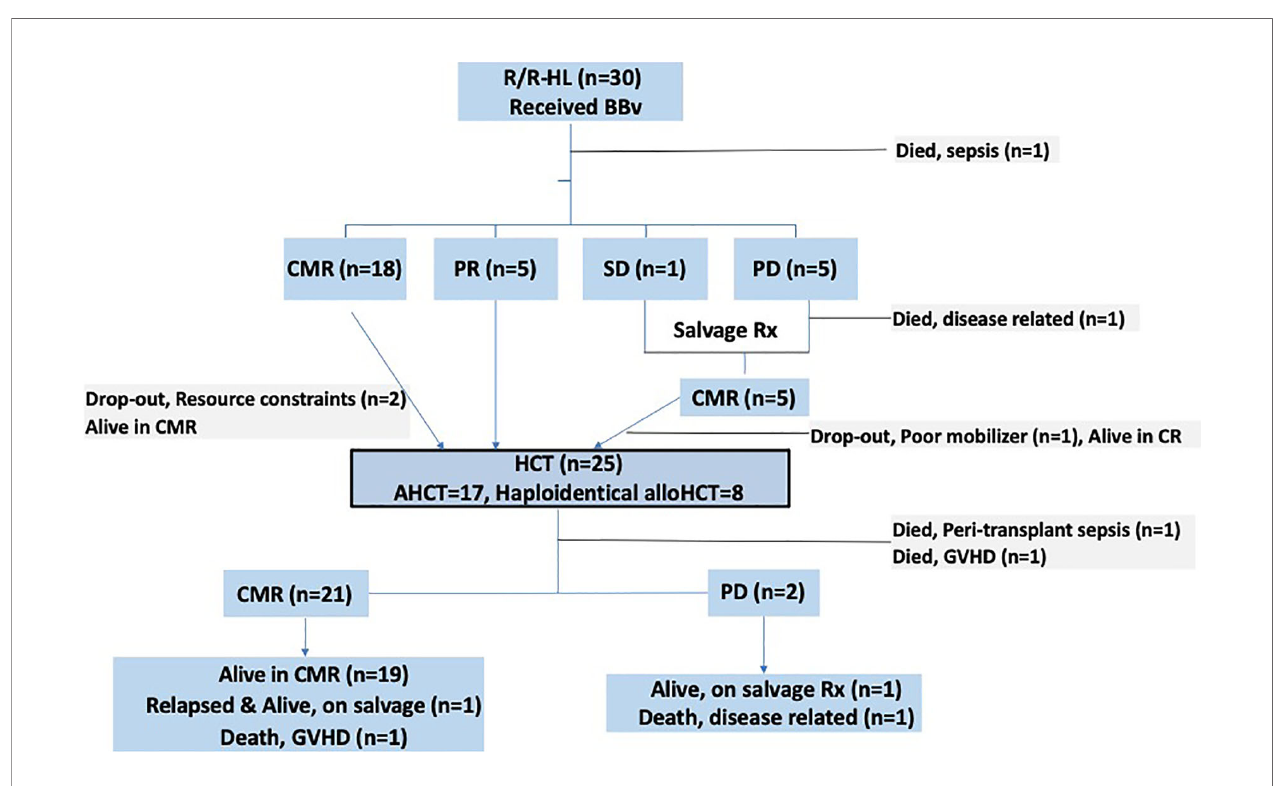
FIGURE 1 | Patient fl ow diagram of the